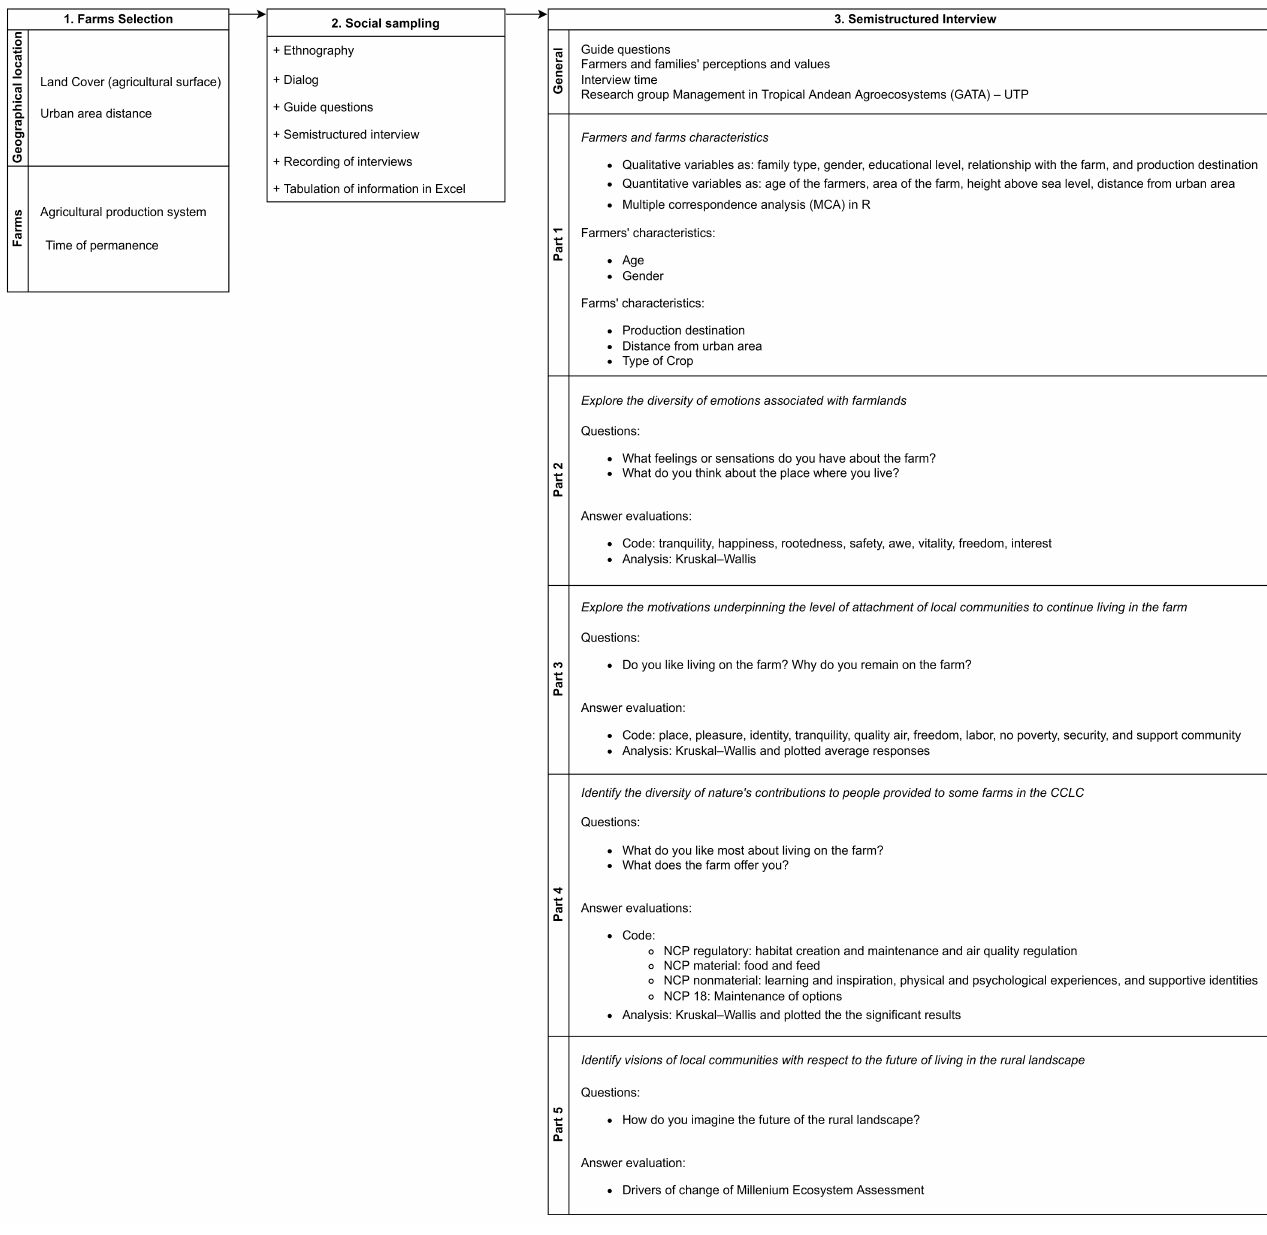
Figure 3. Methodological steps of the research